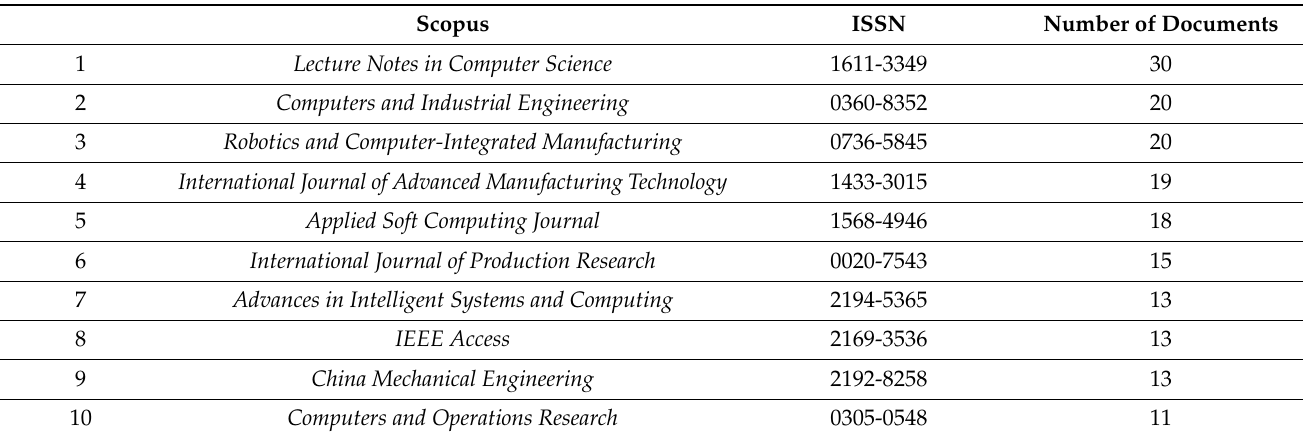
Table 12. The top 10 productive Scopus